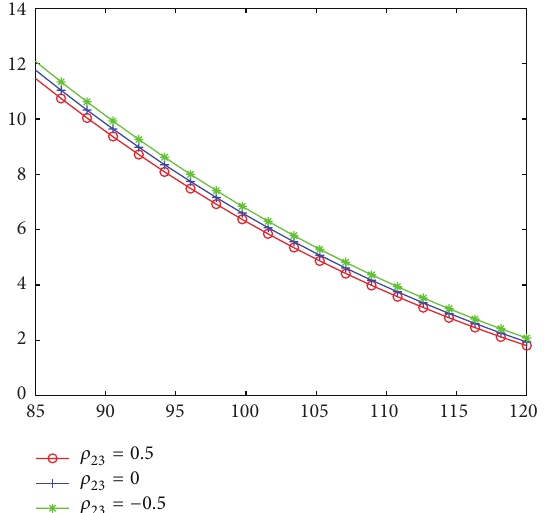
Figure 3: The influence of default covariance 𝜌 23 .